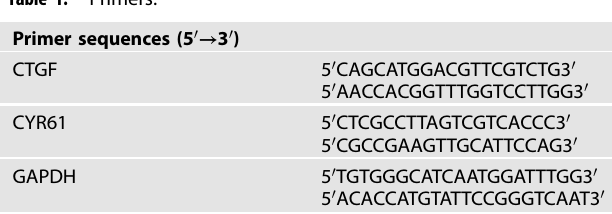
Supplementary Fig. 2A, B, Table 2. The western blotting results revealed the upregulation of cleaved PARP and cleaved Caspase-3 after irradiation with a single 5 Gy dose. However, the increase was signi fi cantly enhanced by P130cas depletion in H1299 cells and was attenuated by P130cas overexpression in A549 and H460 cells (Fig. 2D and Supplementary Fig. 2C, D). Furthermore, after irradiation, the expression of γ -H2AX (phosphorylation of Ser139 on the H2AX variant), which occurs in response to double-strand DNA breaks and serves as a platform for recruitment of DNA repair mediators, was continuously increased in control H1299, A549 and H460 cells over time. In contrast, the tendency was enhanced or delayed in P130cas-knocking down or -overexpressing cells (Fig. 2D, E and Supplementary Fig. 2C – F). The levels of γ -H2AX in irradiated LLC cells were also decreased by P130cas over- expression (Supplementary Fig. 2G, H). Similar results were obtained in vivo that the xenografts derived from cancer